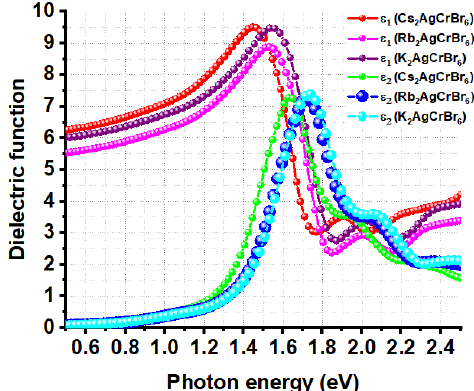
Figure 5. Illustration of the dependence of the real and imaginary parts ( ε 1 and ε 2 , respectively) of the dielectric function ε on the photon energy for A 2 AgCrBr 6 ( A = Cs, Rb, K) double perovskites.